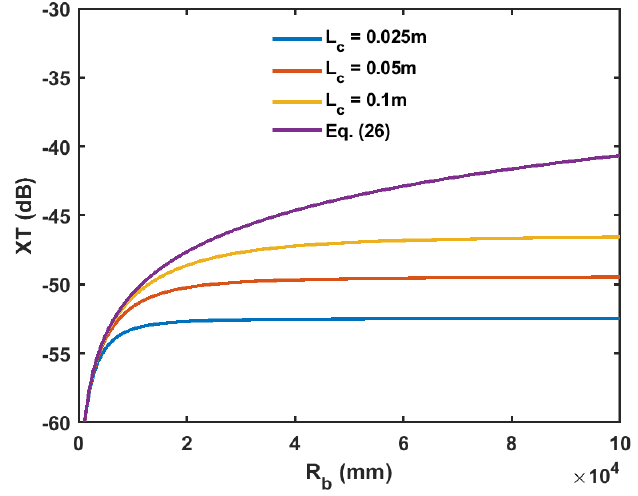
Figure 4. Crosstalk vs. the bending radius R for Equation (25) for various 𝐿 𝑐 and Equation (26). For heterogeneous MCF, for the case of a ≪ 1, b ≫ 1 and |𝑐| ≪ 𝑏 , we can simplify Equa- tion (23) and derive